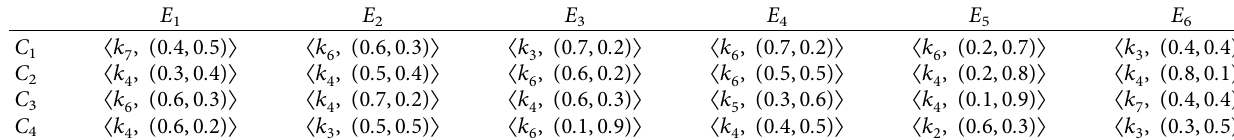
Table 6: Intuitionistic linguistic matrix-expert 4.